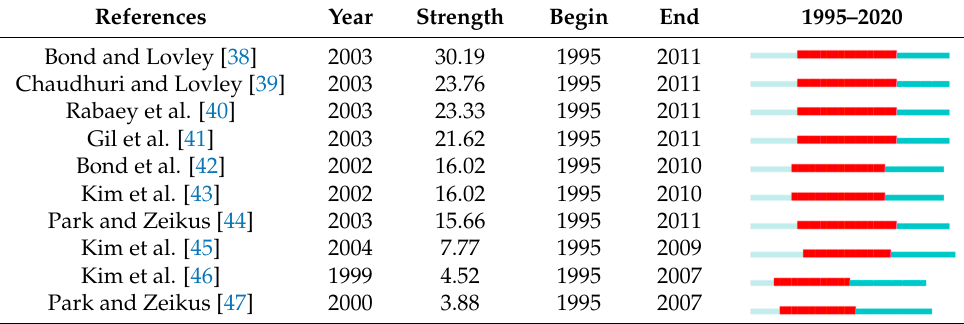
Table 8. The top 10 references with strongest citation